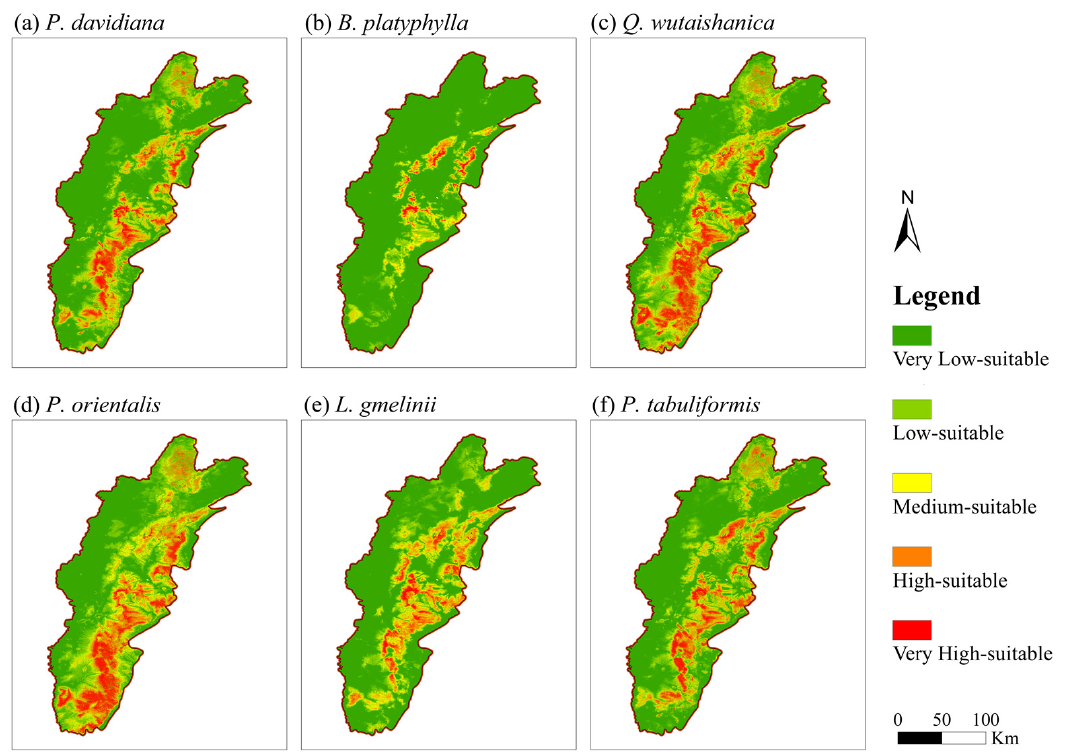
Figure 7. Marginal probability of different forest species that meet the SOC content requirements. ( a ) P. davidiana , ( b ) B. platyphylla , ( c ) Q. wutaishanica , ( d ) P. orientalis , ( e ) L. gmelinii , ( f ) P. tabuliformis.